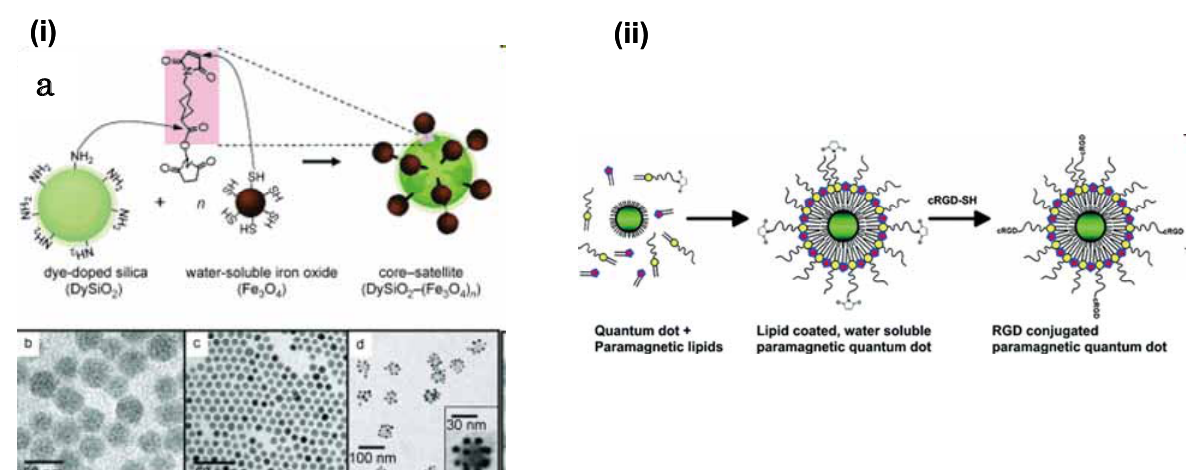
Fig. 3 (i) a) Schematic diagram for the synthesis of core-satellite DySiO images of b) rhodamine-doped silica (DySiO (Fe O ) n nanoparticles. (ii) Schematic representation of quantum dots coated with paramagnetic 3 4